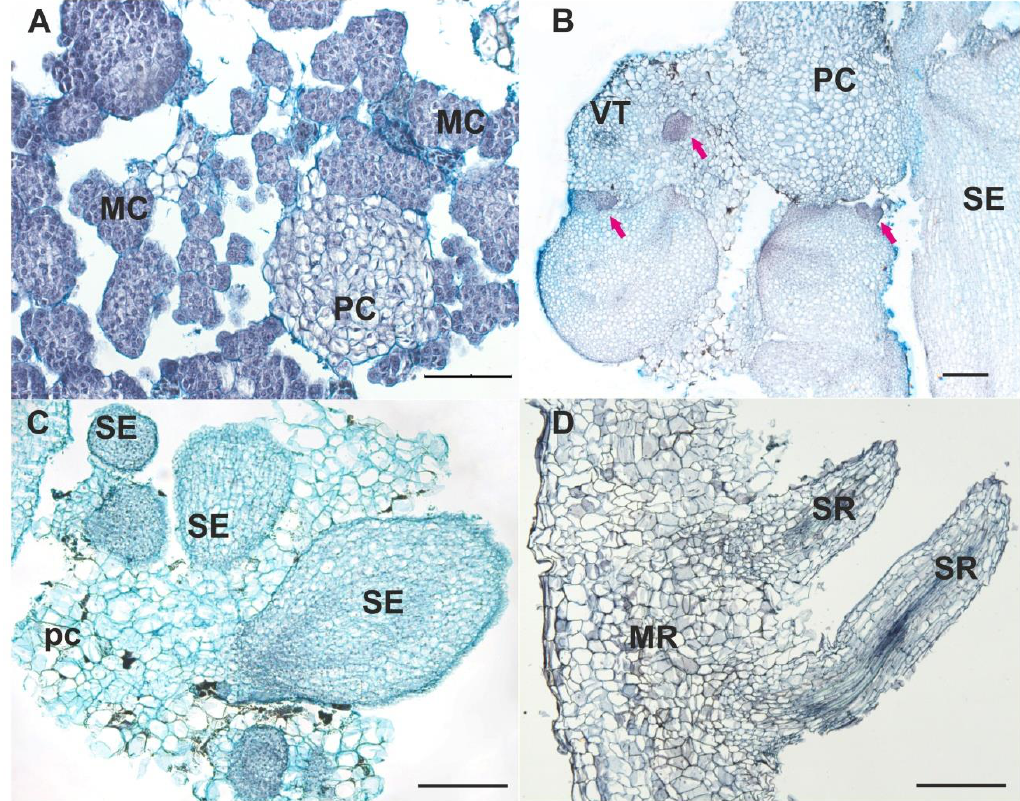
Figure 2. Histology of the S. glabra cell lines. ( A ) Parental proembryogenic cell line S1. ( B ) Morphogenic cell line S2 with SEs and initial meristematic centers (pink arrows). ( C ) Different stages of SEs in the S2 cell line. ( D ) Main root with secondary roots in the S2 cell line. MC, meristematic cells; PC, parenchymal cell; SE, somatic embryo; VT, vascular tissue; MR, main root; SR, secondary root. Bars, 200 µM.